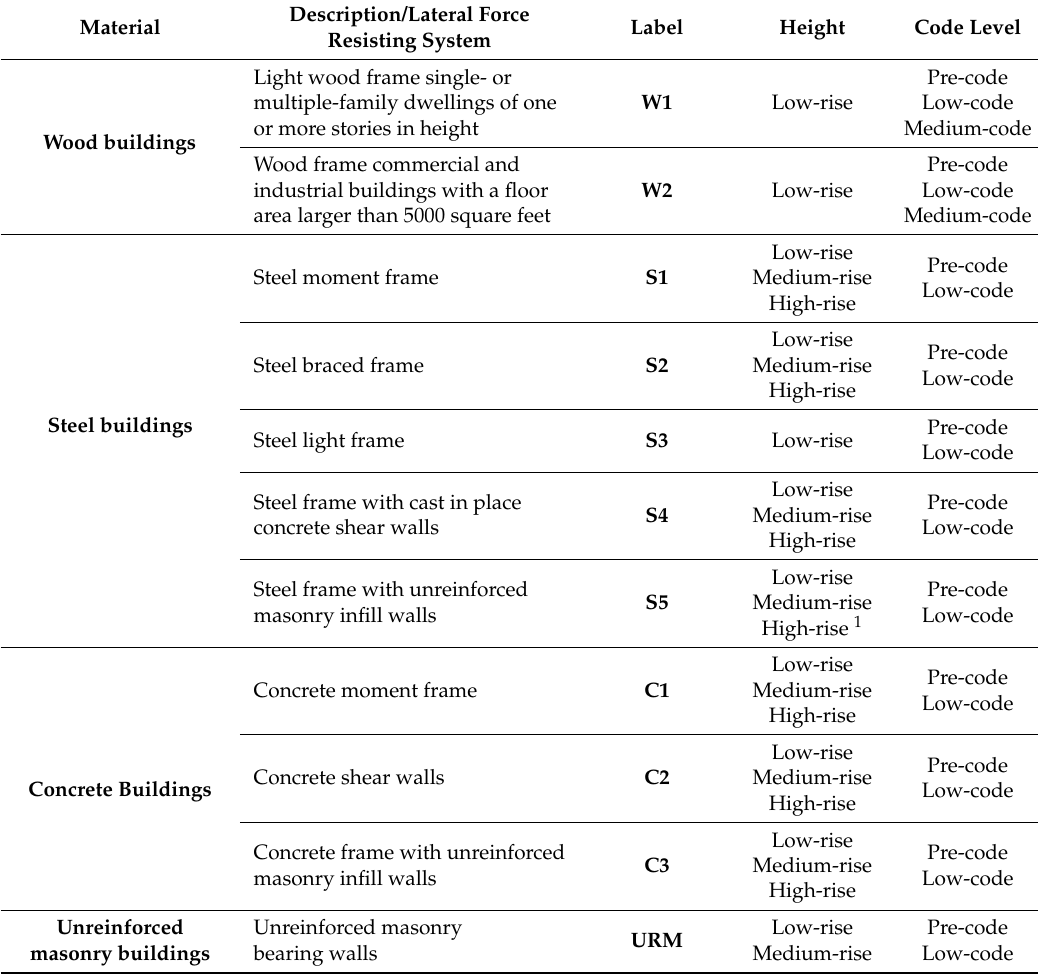
Table 1. The 53 most frequent building